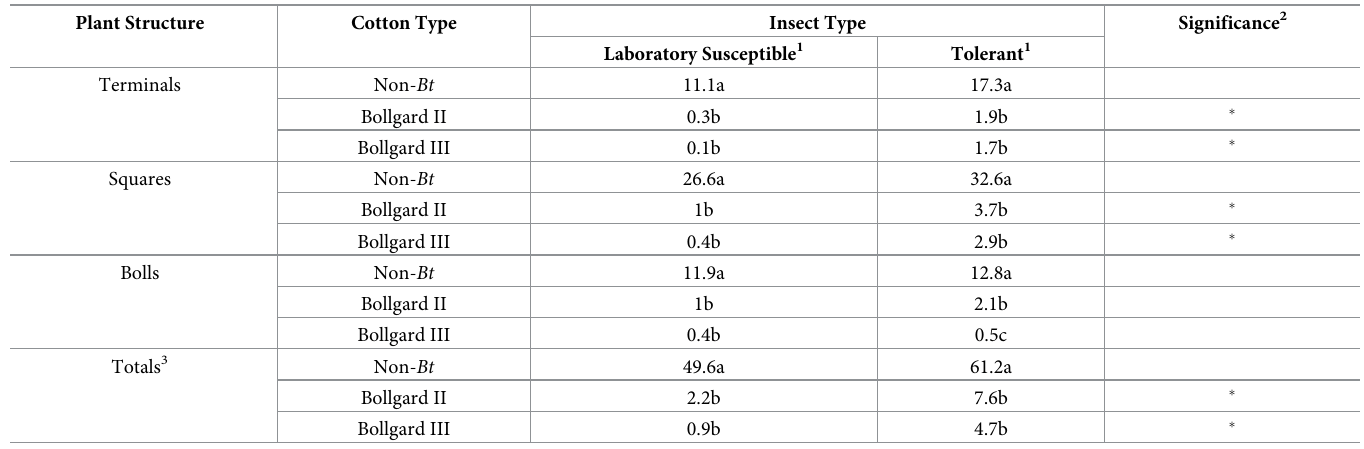
Table 3. Cumulative terminal, square, and boll damage caused by H . zea per 25 plants at final rating period. Plant